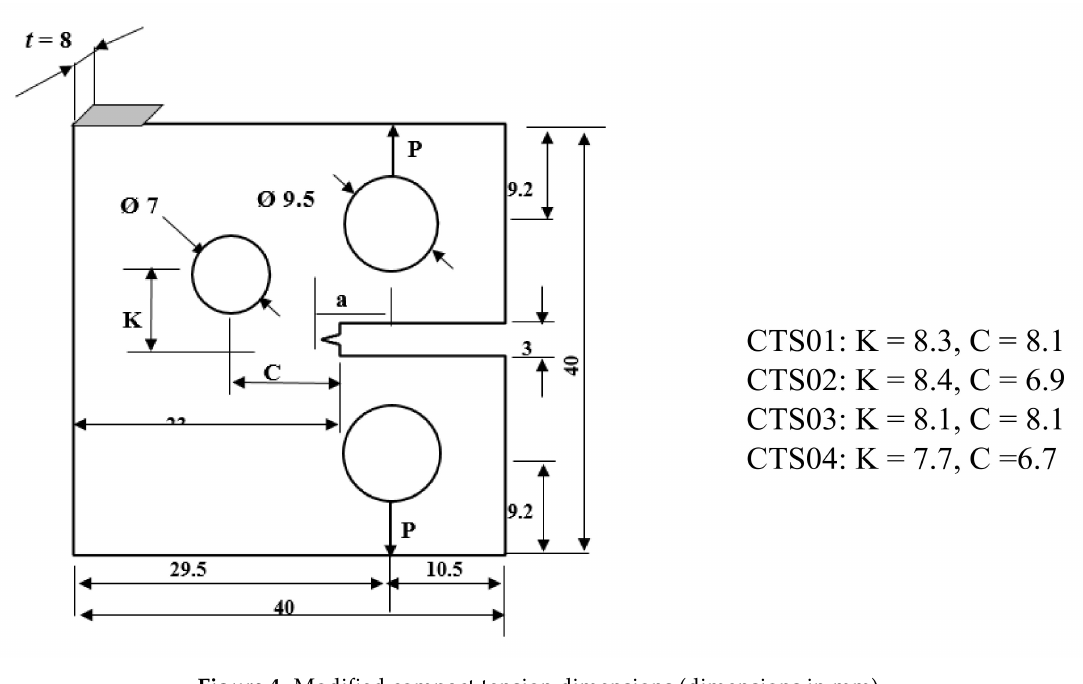
Figure 4. Modified compact tension dimensions (dimensions in mm).